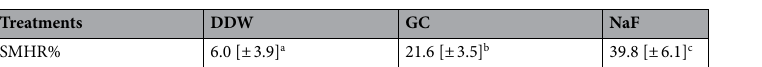
Table 1. The percentage of surface microhardness recovery (SMHR%) (Mean [± SD]). Different superscript letters indicate a significant difference between groups (p < 0.05). DDW samples treated with double distilled